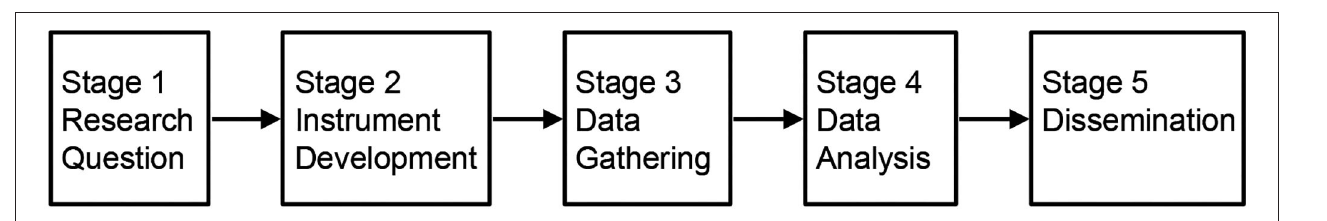
FIGURE 2 | The five-stage research process (Stuart et al.,